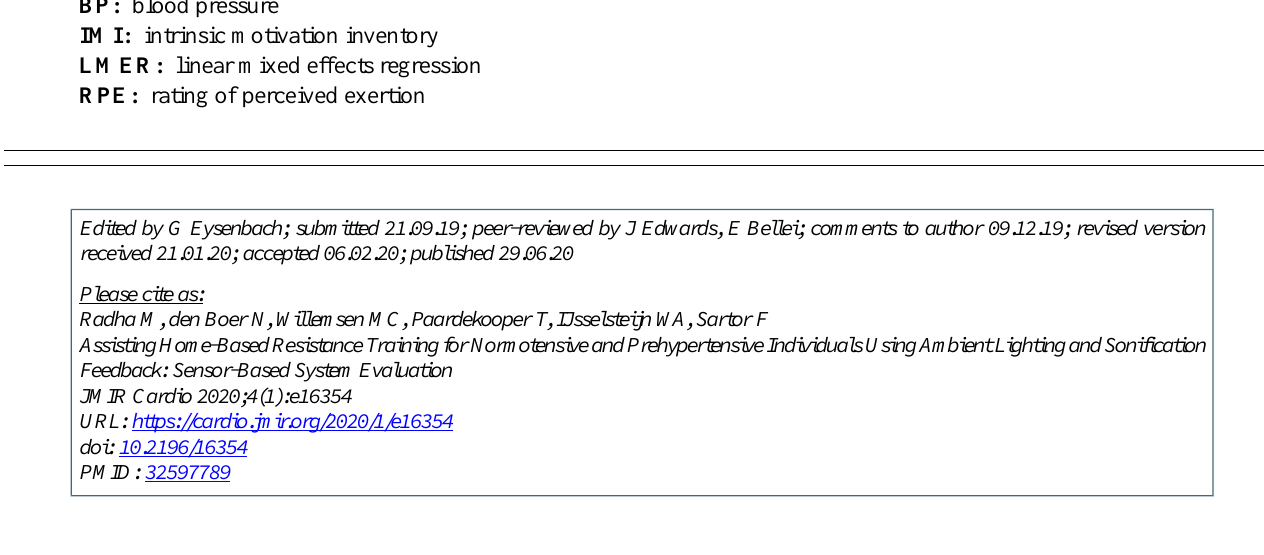
IMI: intrinsic motivation inventory LMER: linear mixed effects